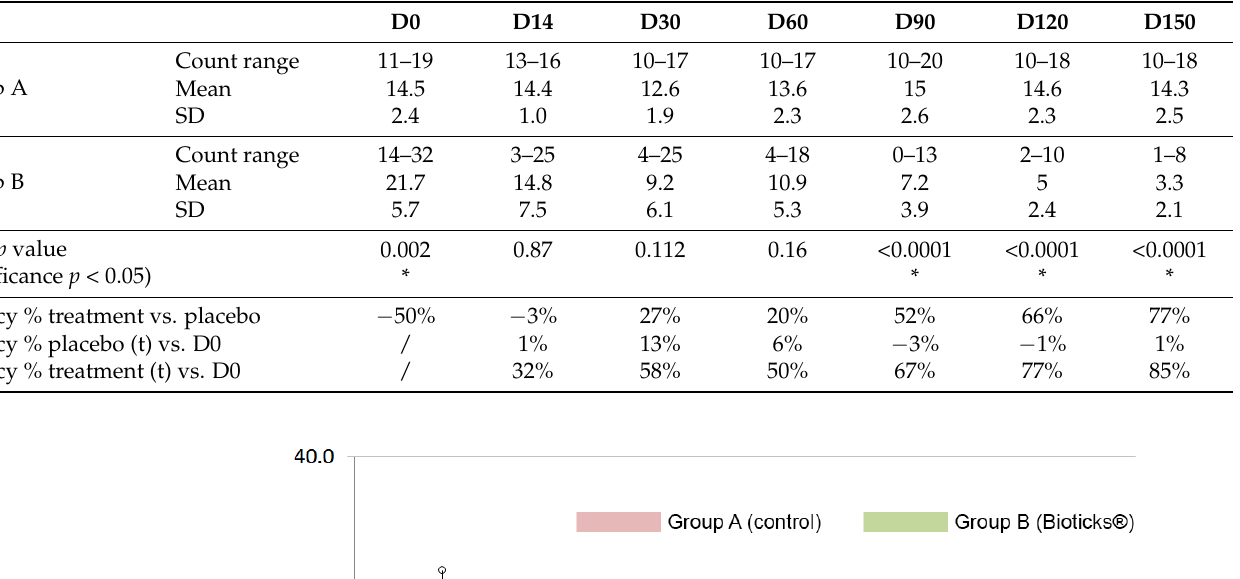
Table 1. Flea counts and efficacy calculation (SD: standard deviation; *: significant difference be- tween groups).